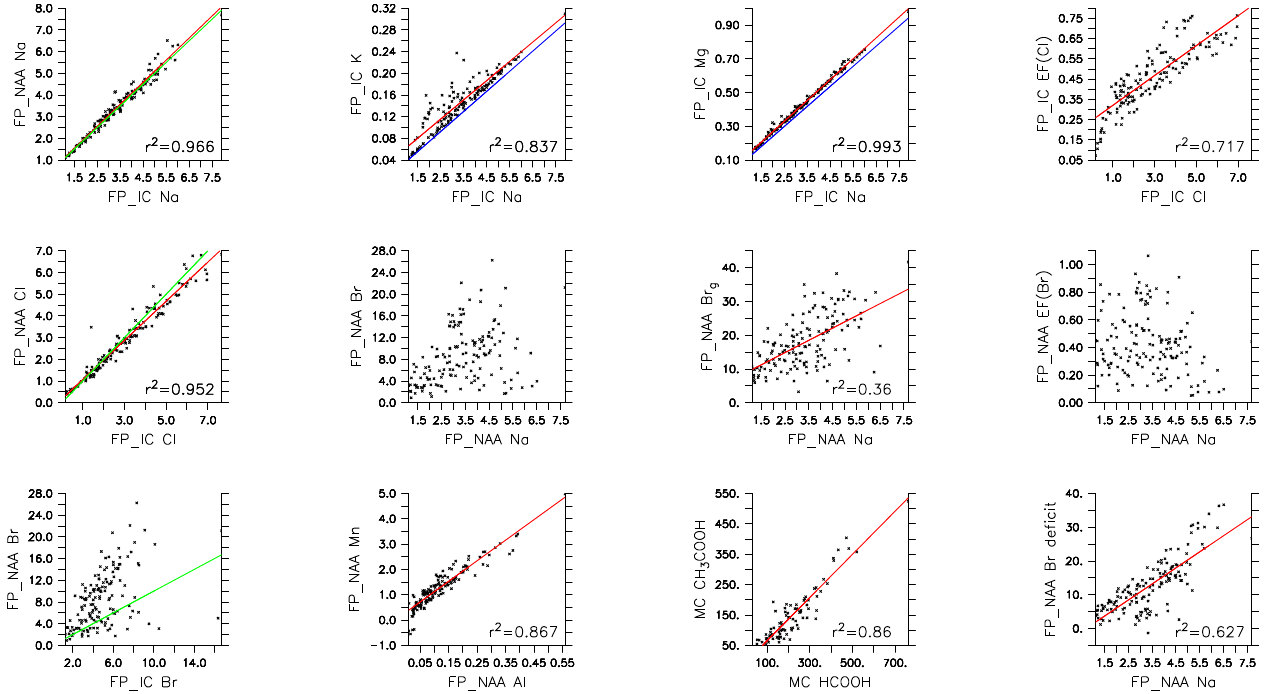
Figure 10. Scatter plots. The first column shows comparisons between filter pack samples analyzed by neutron activation (prefix FP_NAA) and ion chromatography (prefix FP_IC), respectively, with a 1 : 1 line in green. The second and third columns show correlations between selected data, where the prefix MC refers to mist chamber data, and a blue line indicates the sea water composition. Finally, the last column shows correlations to the derived quantities enrichment factor and deficit, as defined in Sect. 4. The units of all plots are the same as listed in Table 1. Regression lines in red are only shown if r 2 > 0 .